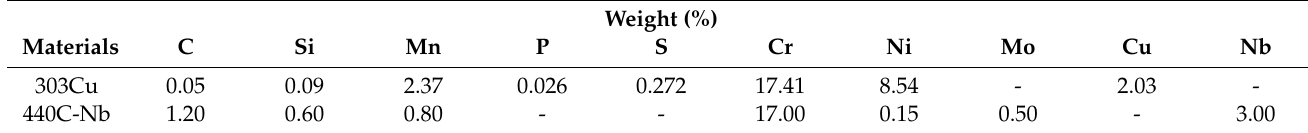
Figure 1. Schematic diagram of test object and welding position. Table 1. Chemical composition of materials.